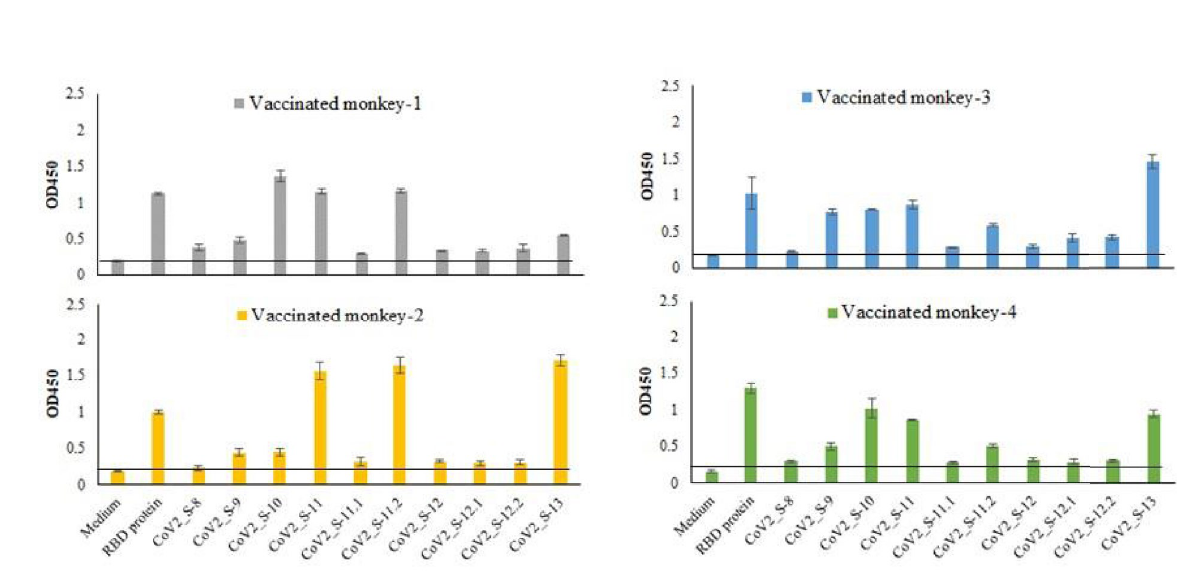
Figure 1. Antibody responses against predicted RBD epitopes in sera from vaccinated monkeys. ( A ) Antibody response against each predicted B cell epitope in the RBD. ( B ) Number of sera in the vaccinated group reacting with each peptide based on the criteria set. ( C ) Patterns of antibody responses in different monkeys. ELISA was performed with the synthetic peptide of each predicted epitope to determine antibody response in eight monkeys vaccinated with plant-produced RBD subunit and five control monkeys. Sera were diluted 1:100. * and ** indicates OD450 values in the control and vaccinated groups that are significantly different with p -value < 0.05 and 0.001, respectively. ns: not statistically